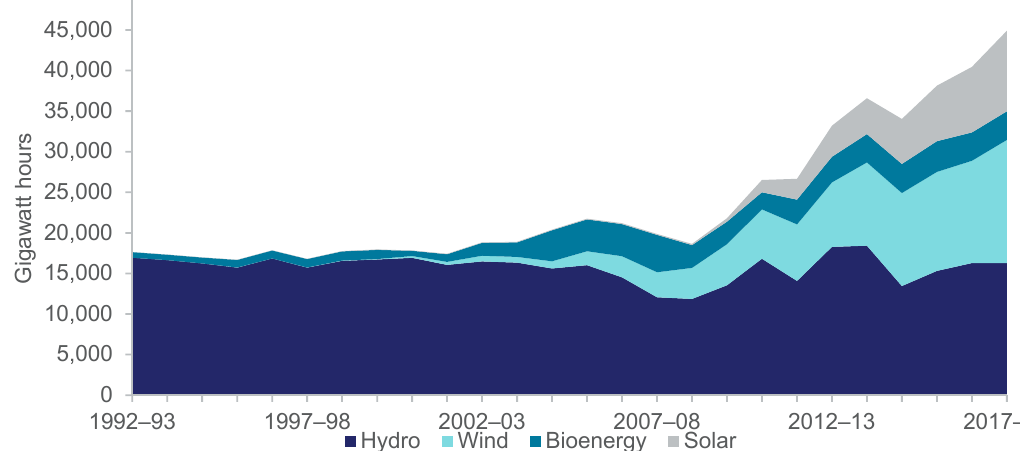
Figure 1. Australian electricity generation from renewable sources, as shown in Australian Energy Statistics (Australian Government Statistics, 2019).